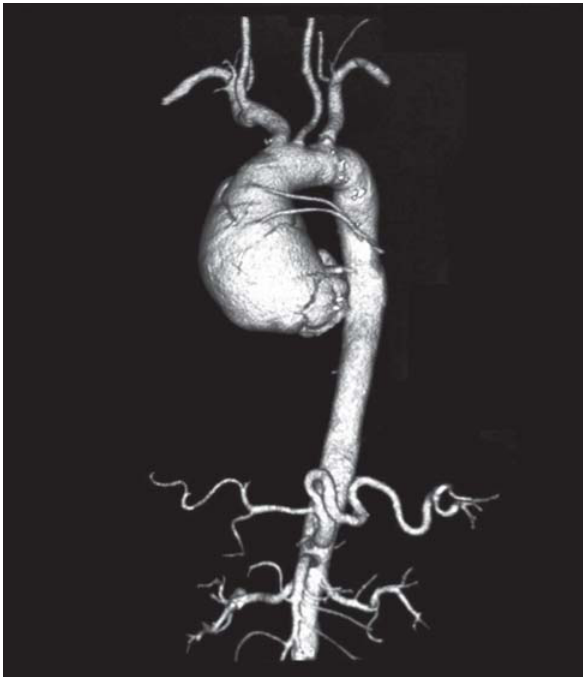
Fig.1 - Dissecção crônica do tipo A em paciente revascularizado